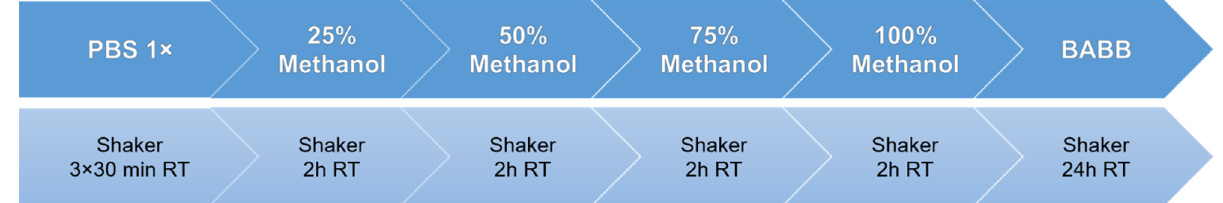
Figure 3. Benzyl Alcohol/Benzyl Benzoate (BABB) clearing protocol.